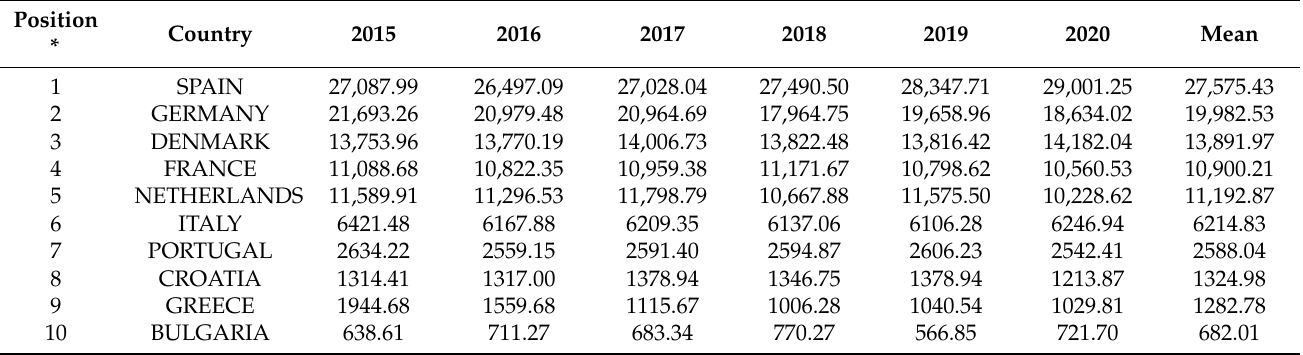
Table 7. Results of N 2 O emissions from manure management using Tier 2 methodology (Gg CO 2 -